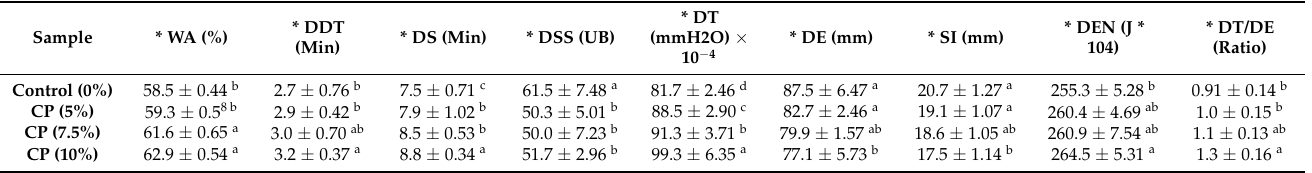
Table 4. Farinograph and alveograph tests results of chocolate cookie